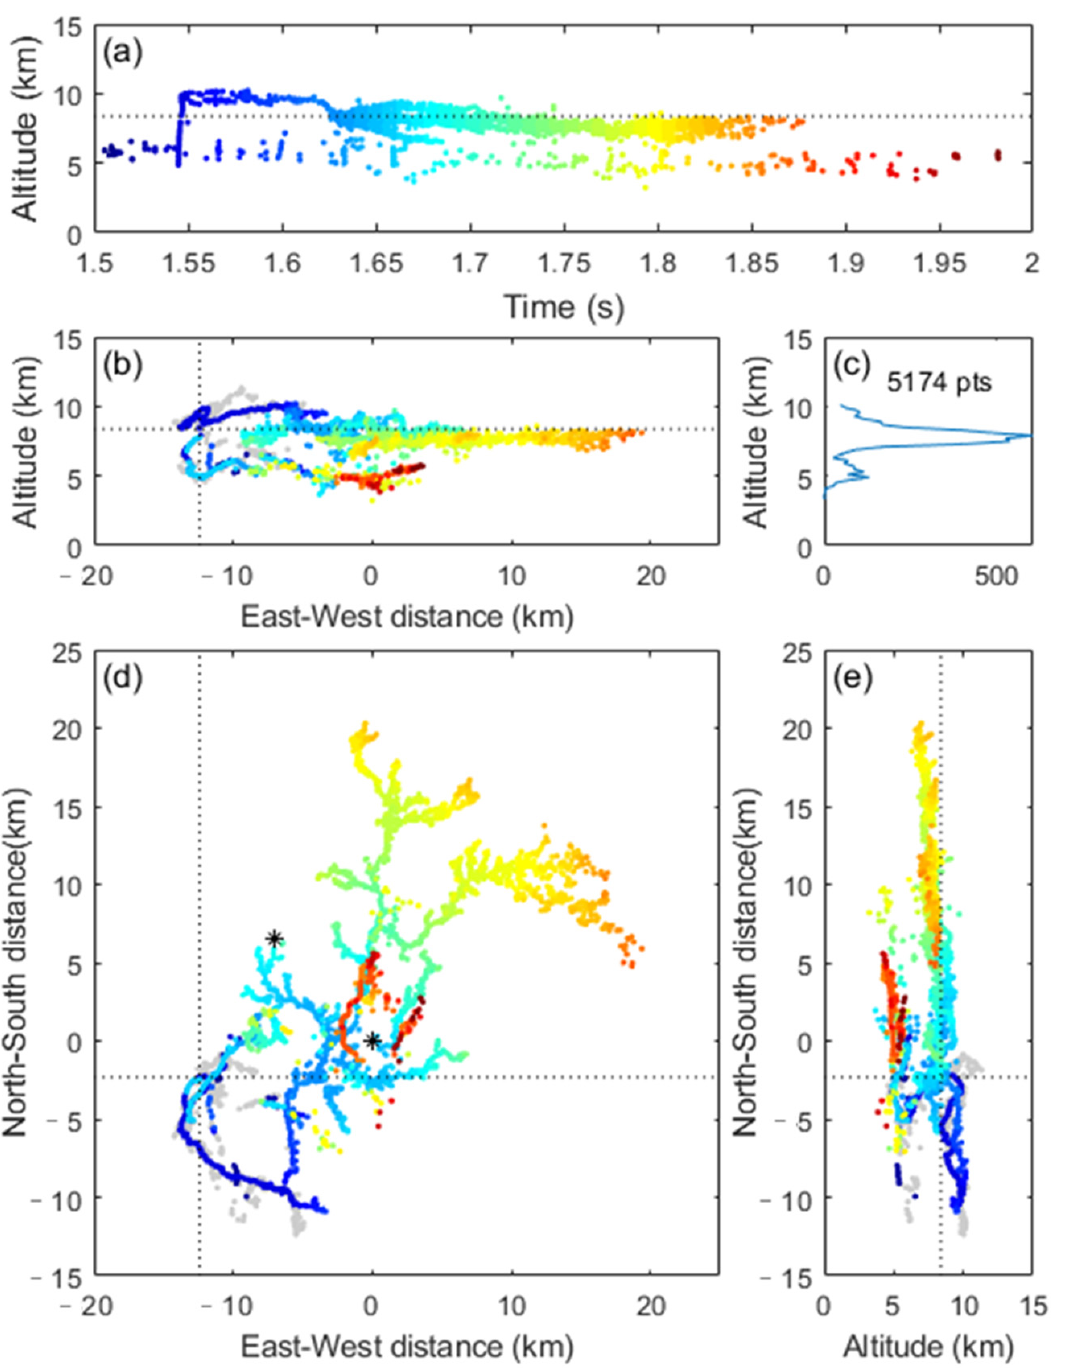
Figure 5. Three-dimensional location results of the late stage of the IC flash in Figure 4. ( a ) height with time, ( b ) north–south vertical projection, ( c ) height distribution of the number of radiation sources, ( d ) plane projection, and ( e ) east–west vertical projection of the three-dimensional location result. Asterisks are positions of the interferometer. Dashed lines intersect at the initiation point of the